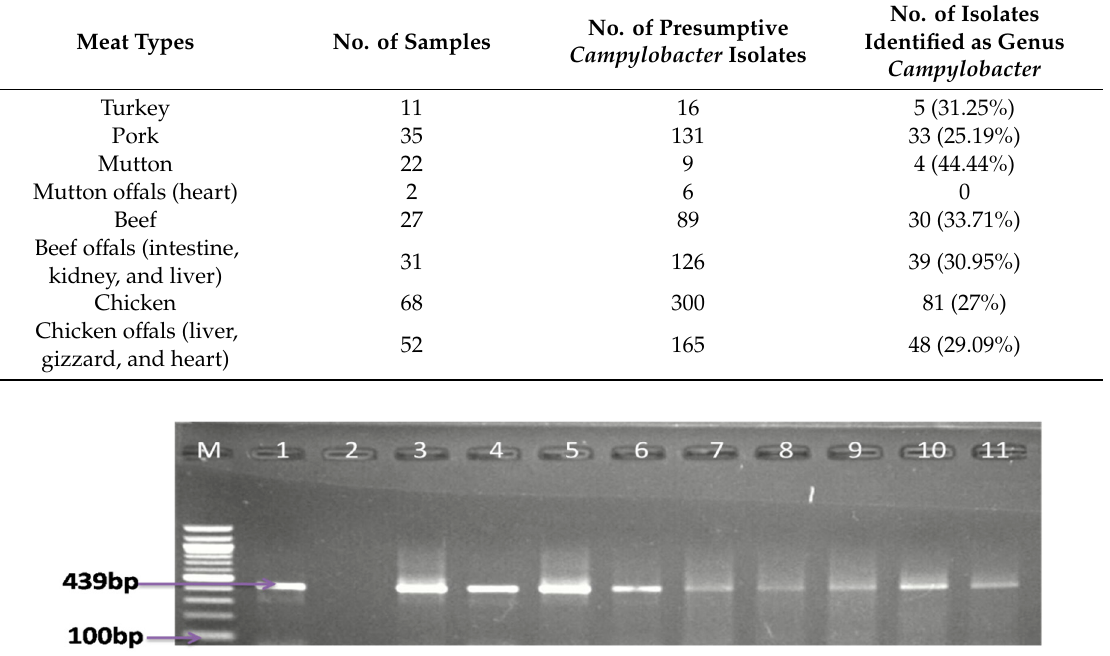
Figure 2. Agarose gel electrophoresis image of PCR-confirmed genus Campylobacter . Lane M: molecular marker (100 bp); lane 1: positive control ( C. jejuni ATCC 33560); lane 2: negative control; and lanes 3 − 11: positive Campylobacter isolates (439 bp).